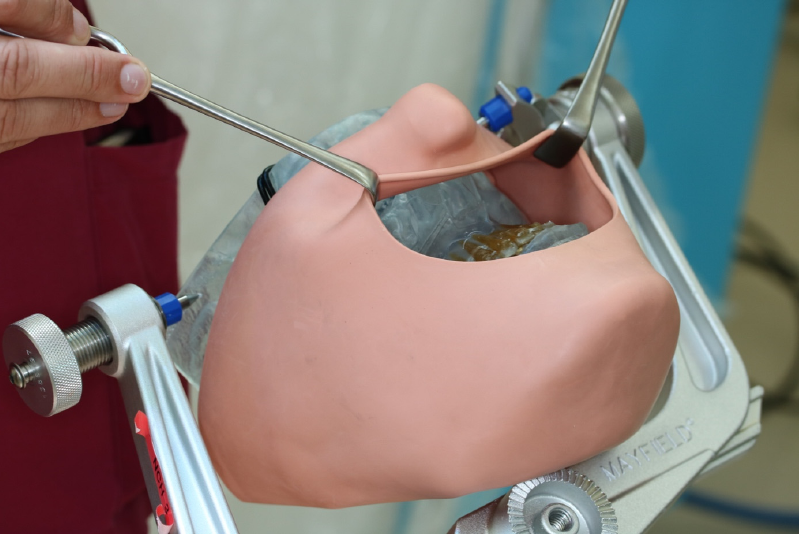
Figure 4. 3D printed patient model fixed in the Mayfield clamp and soft tissue mask.